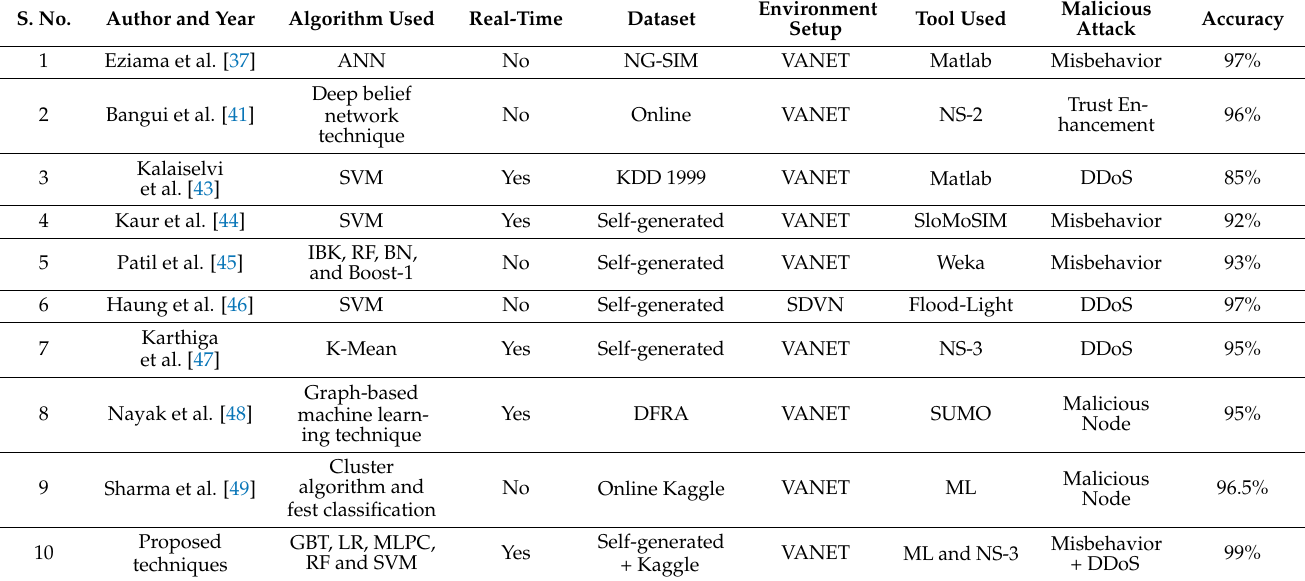
Table 1. Comparison of different existing state-of-the-art techniques under multiple